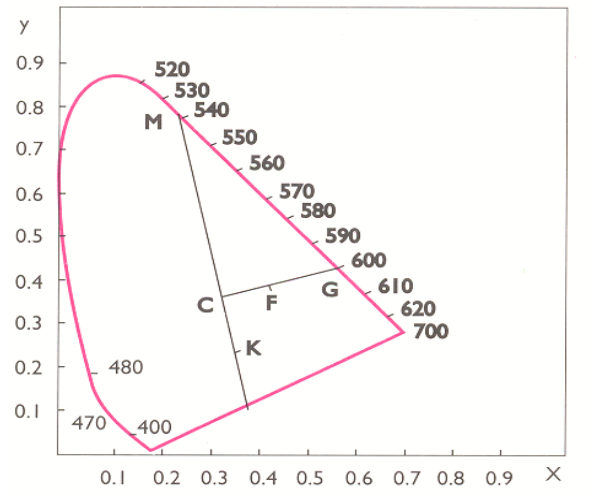
Figure 1 . Determination of dominant wavelength and purity of color by CIE